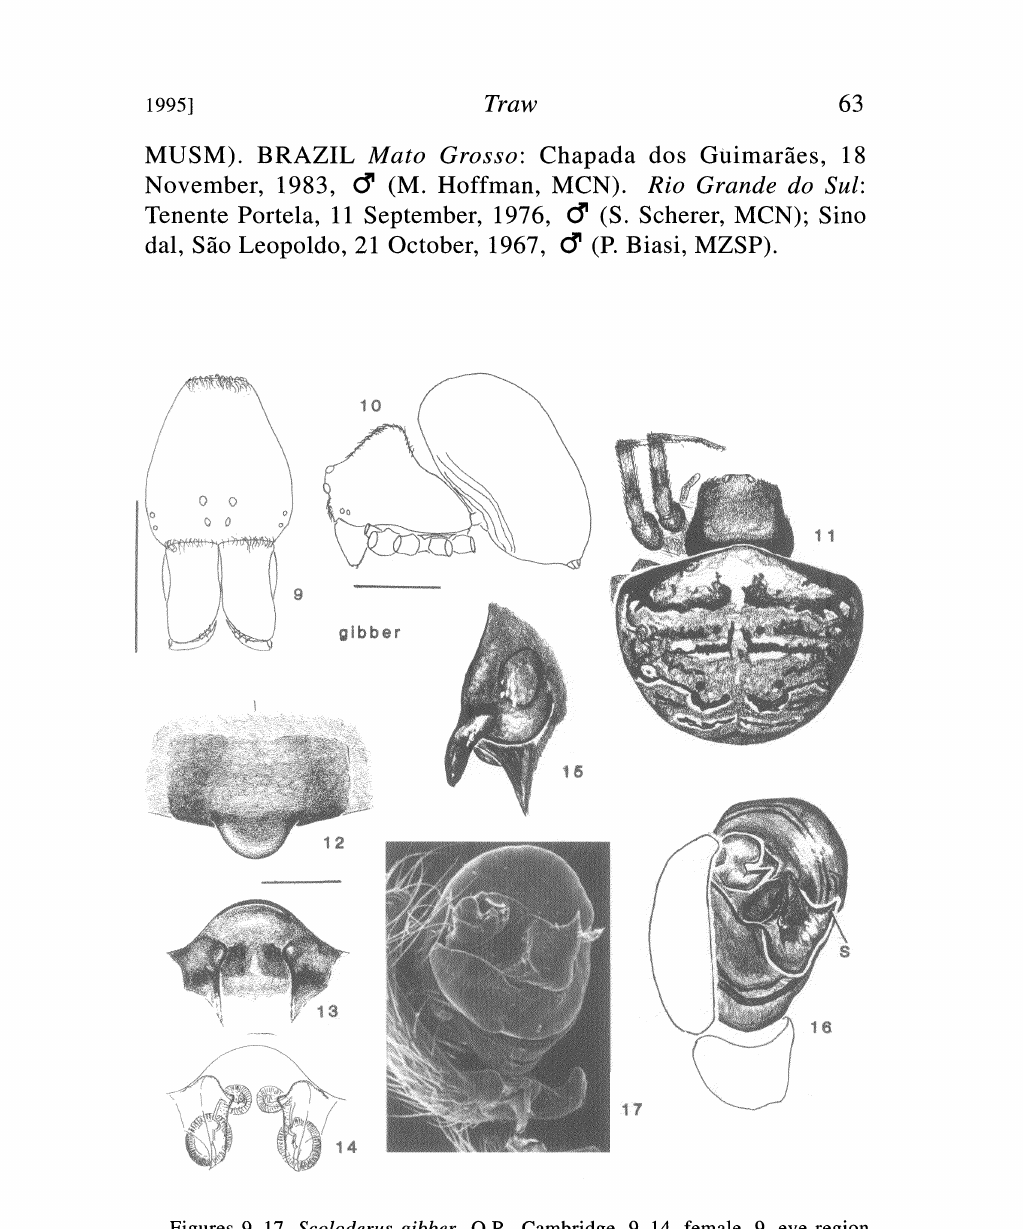
Figures 9-17. Scoloderus gibber O.P. -Cambridge. 9-14, female. 9, eye region and chelicerae. 10, lateral. 11, dorsal. 12-15, epigynum. 12, ventral. 13, posterior. 14, cleared. 15, lateral. 16, 17, left male palpus. Scale lines, mm; genitalia 0.1 mm. Abbreviation, S,